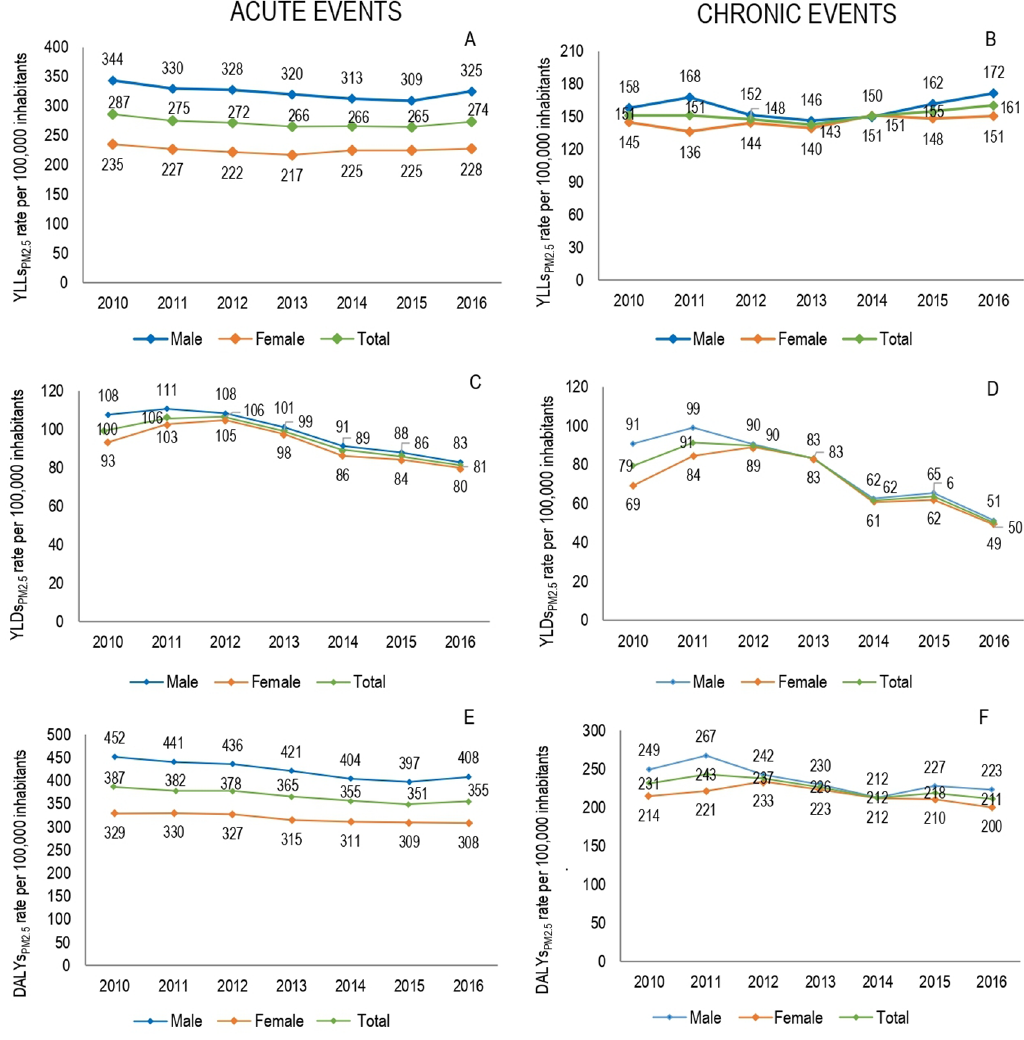
Figure 2. Attributable local burden disease to ambient PM 2.5 pollution by gender, 2010-2016. YLLs PM2.5: Attrib- utable years of life lost toambient PM 2.5 pollution. YLDs PM2.5: Attributable years lived with disability toambient PM 2.5 pollution. DALYs PM2.5 : Attributable disability adjusted life years to ambient PM 2.5